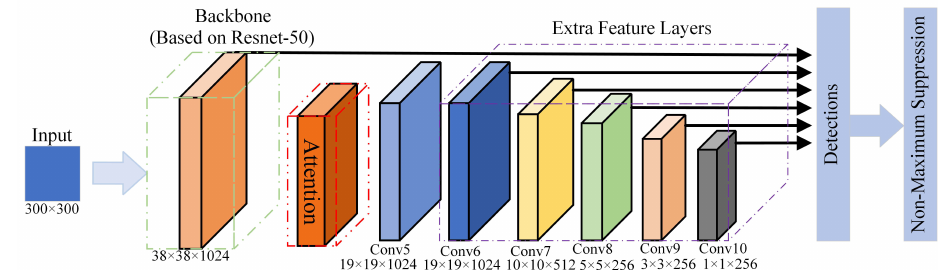
Figure 2. Improved SSD algorithm architecture.